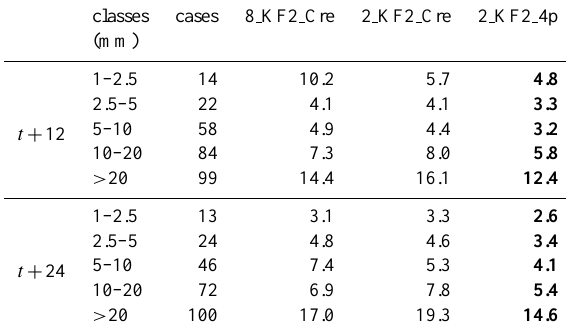
Fig. 3. Flow diagram representing the process followed. The first three rows represent the three domains and the CPS choices in each of them. In the fourth row, the techniques used for the estimation of precipitation forecasts at the locations of the stations are presented. Underneath, the abbreviations used for each process are given (for example: 8_KF2_Cre means that these results come from the 8km grid with Kain-Fritsch-2 CPS and the Cressman interpolation method). Finally, in the coloured boxes, the questions investigated in the present work by comparing results of certain procedures are shown.